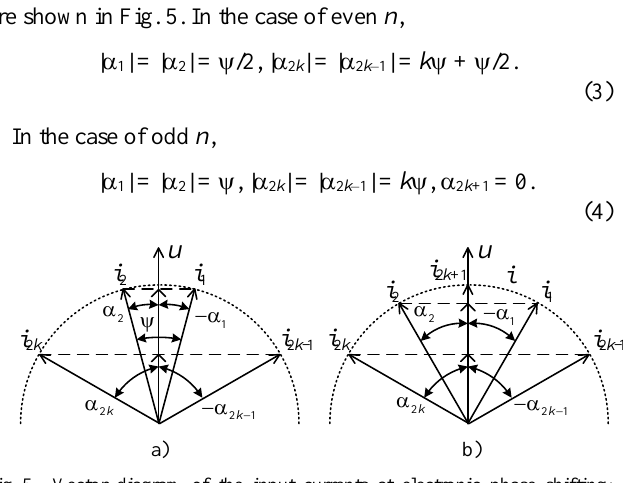
Fig. 5. Vector diagram of the input currents at electronic phase shifting: a) n = 2 k , b) n = 2 k +